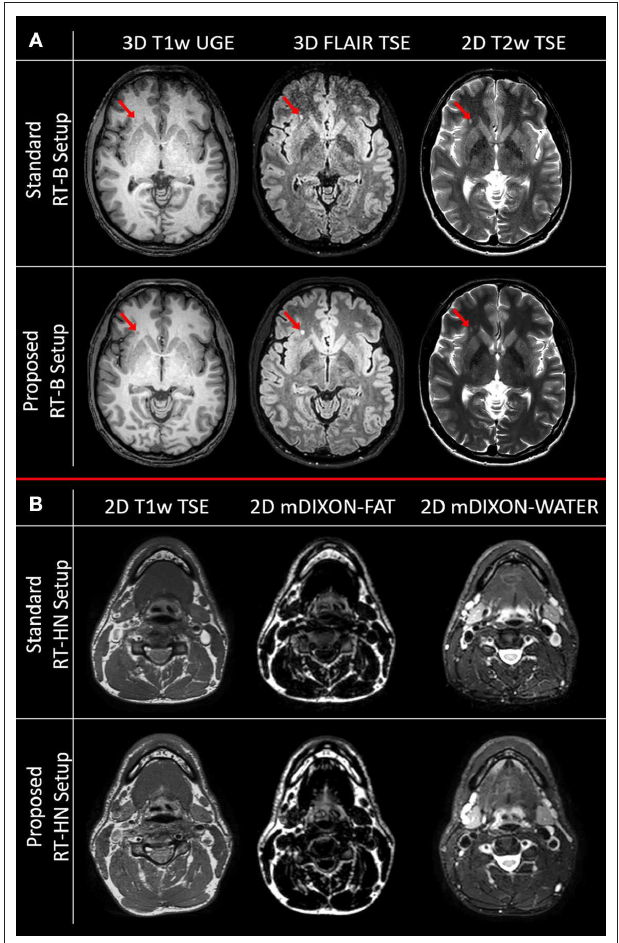
FIGURE 3 | Image quality comparison for clinically acquired brain (A) and head-and-neck (B) MRI sequences for the standard and the proposed setups. The red arrows indicate a white matter